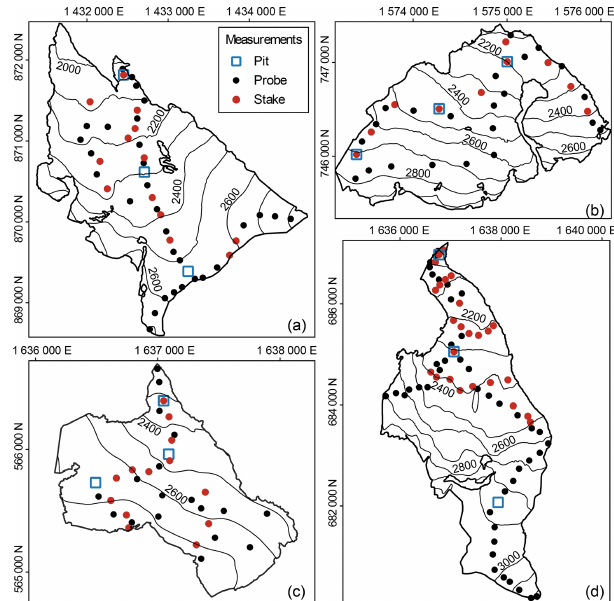
Figure 4. Measurement networks for the (a) Zillmer, (b) Nordic, (c) Kokanee, and (d) Conrad glaciers. Snow depth measurement lo- cations, ablation stakes, and snow pit/core locations are pictured. Refer to Marshall (2014) for the Haig Glacier and to Hirose and Marshall (2013) for the Illecillewaet Glacier. Map coordinates are in